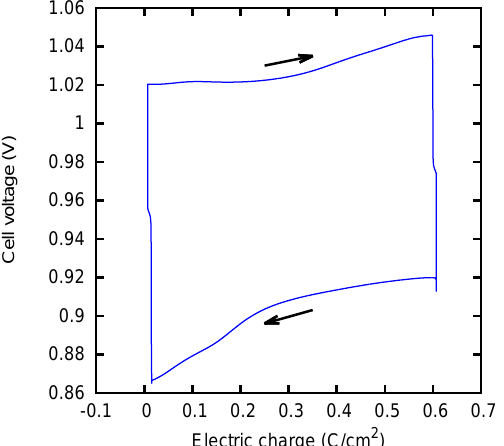
Figure 7. Example of the charge–discharge cycle. The cycle is